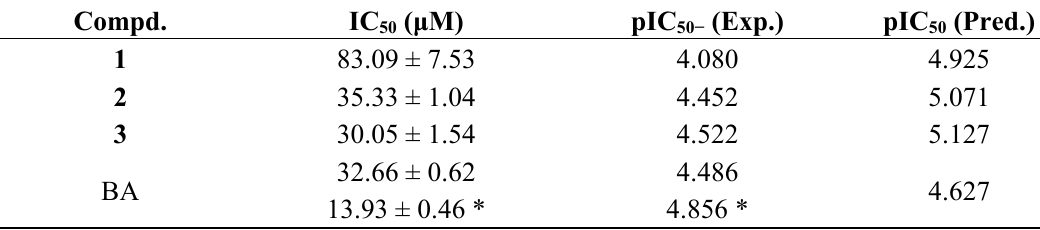
Table 2. The predicted and experimental activity against HT29 cell line.